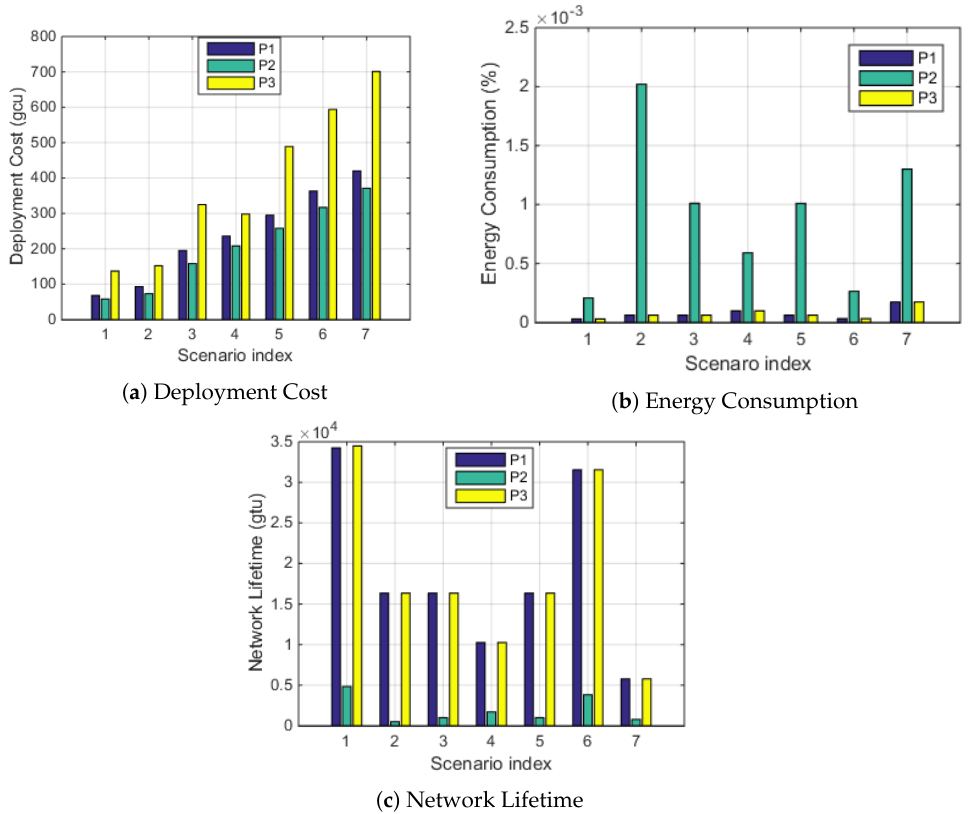
Figure 5. Comparison of P1, P2, and P3 in terms of the deployment cost, energy consumption, and network